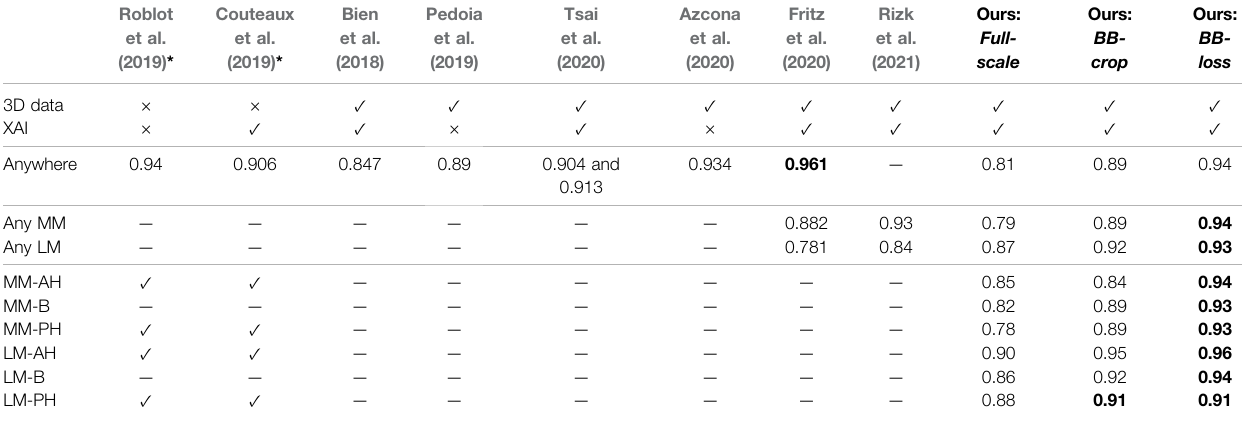
TABLE 4 | Comparison of our results on DESS MRI data to the related work. The “ 3D data ” column indicates whether the method is trained on and applied to complete 3D MR images. The explainable AI “ XAI ” column indicates if concepts of saliency maps are employed in order to highlight the areas responsible for the CNNs ’ decisions. Roblot et